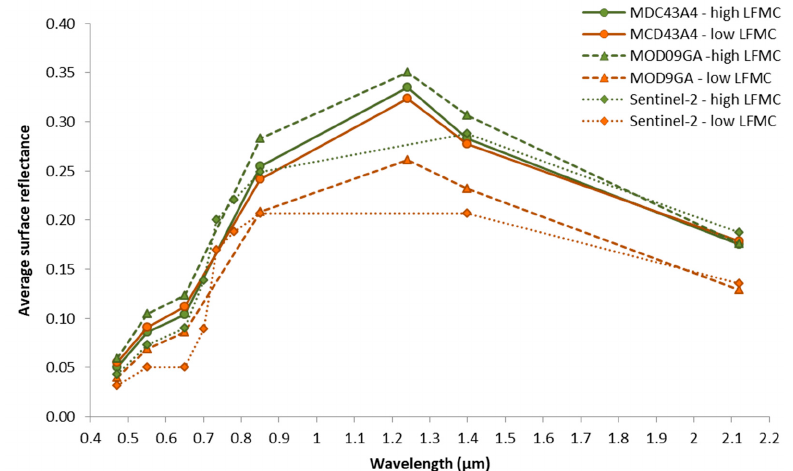
Figure A2. Comparison of spectral reflectance profiles from Sentinel-2 and the composite (MCD43A4) and non-composite (MOD09GA) MODIS products for dates in the 2016 summer period with contrasting values of field measured LFMC: high LFMC = 109% (21 July 2016) and low LFMC = 62% (30 August 2016).